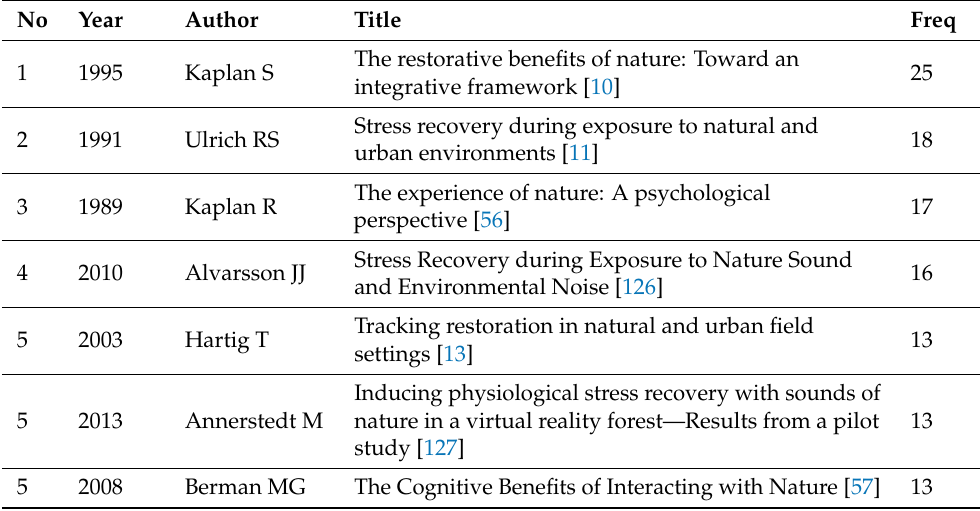
Table 7. Top 5 most cited references of network for the second step of the review, visual stimuli, and visual properties of restorative